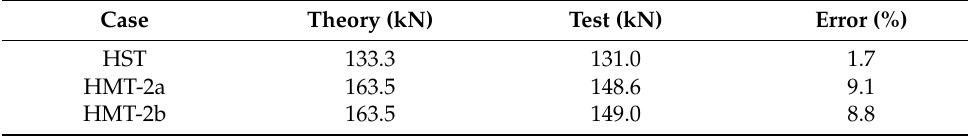
Table 5. Comparisons between theory and test of MCF based on PF